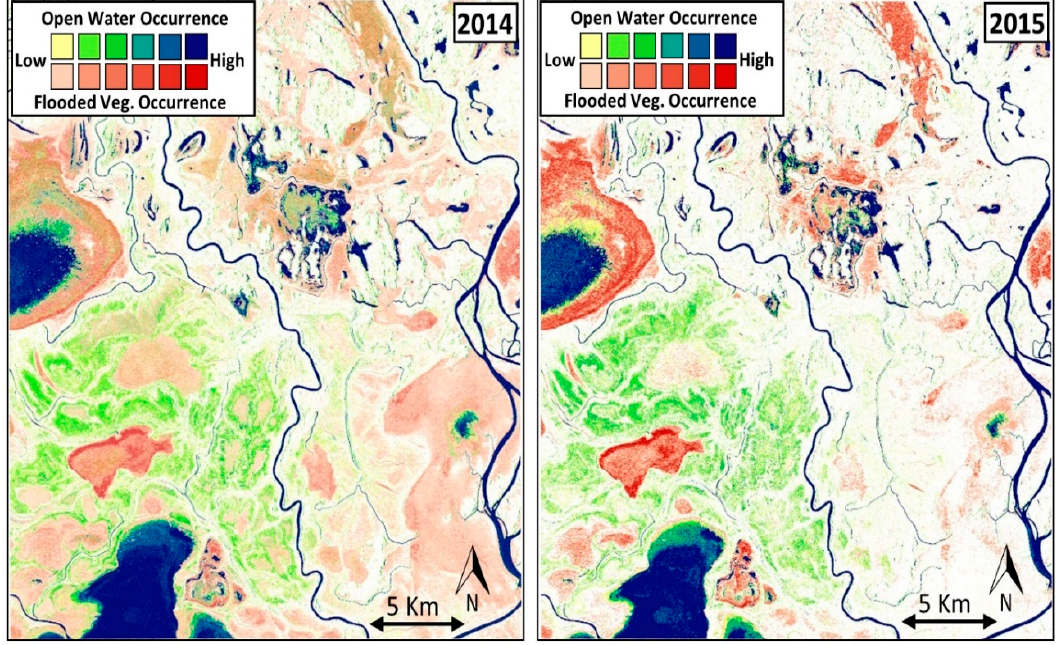
Figure 9. Flooded vegetation and hydroperiod of open water for 2014 and 2016 in the Peace-Athabasca Delta. Flooded vegetation is shown in red, whereas open surface water is shown in yellow to blue.